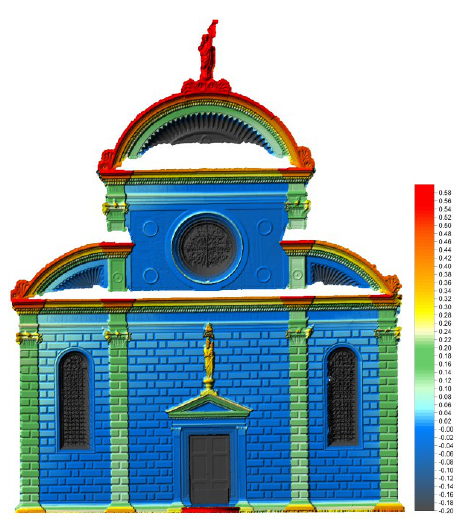
Figure 4. DSM of the facade of the church with “shadow” zone due to entablatures The sum of the four scans has allowed to have, for the sole facade, a cloud of around 45 million points with a step in the lower part lower than around 1 mm and in the upper part around 5